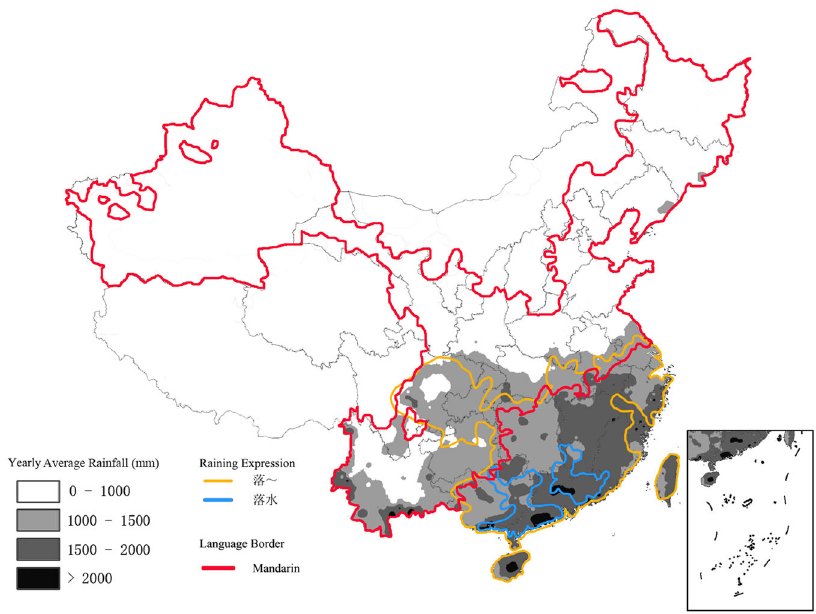
Fig. 2 Map of distribution of rain expressions, yearly average rainfall and Mandarin border. The different shades of greyscale represent yearly average rainfall, the yellow and blue lines are the isoglosses of different raining expressions, the red lines border Mandarin Chinese speaking